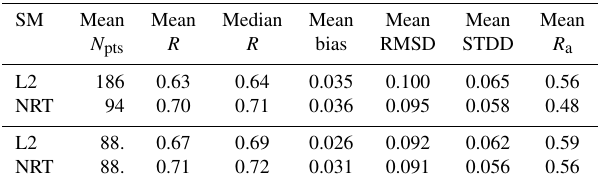
Table 2. SMOS Level 2 and NRT NN SM comparison to in situ measurements over the USCRN and SCAN networks. The columns are as follows: the SM product, the mean number of points in the time series, the mean and median Pearson correlation with respect to in situ measurements, the mean bias (mean in situ SM minus mean SMOS SM), the root mean square and standard deviation of the difference time series averaged over all sites, and the Pearson correlation of the anomalous time series ( R a ). The statistics have been computed independently for the NRT SM NN and the L2 SM product. The number of SM retrievals is, on average, larger for the L2 SM. The two lower rows show the results using only times for which both the NRT SM NN and the L2 SM products are simulta- neously available. SM